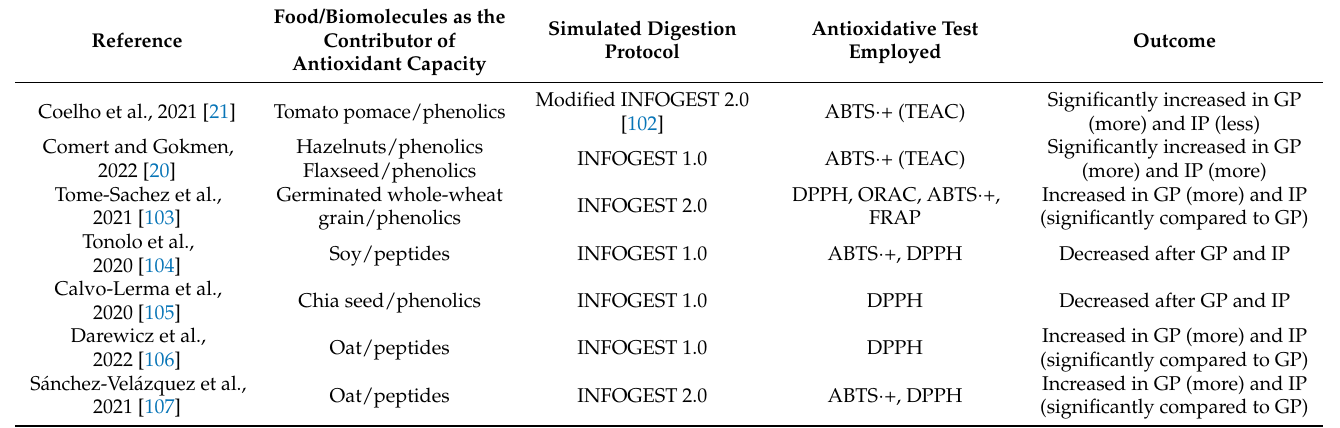
Table 2. Overview of studies assessing the potential change in the antioxidative capacity of protein- rich, plant food sources before and during the simulated gastric/gastrointestinal